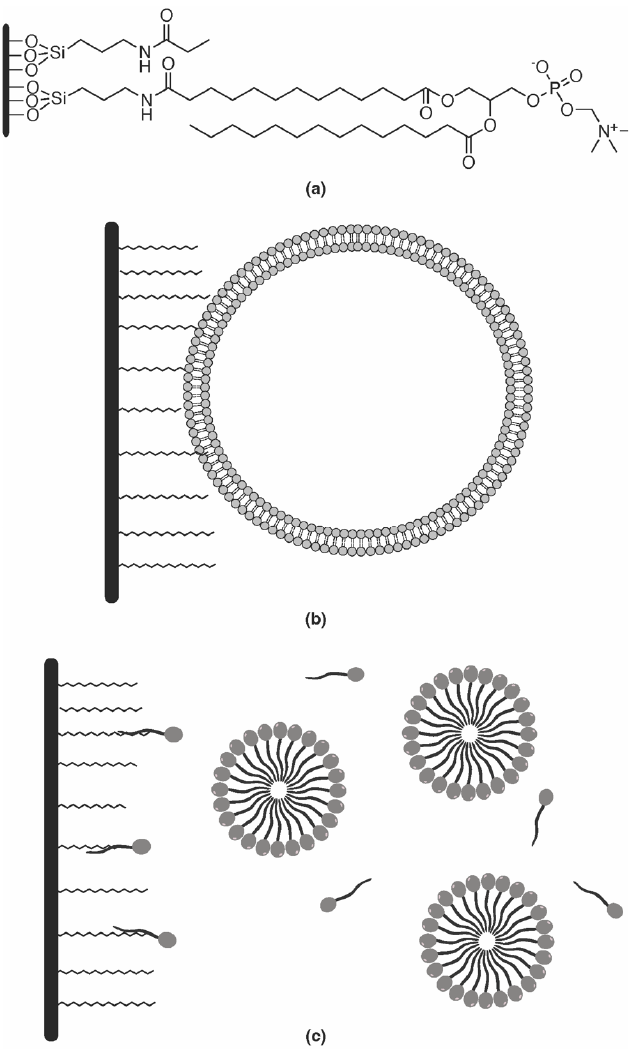
Figure 4. ( a ) IAM HPLC column; ( b ) immobilized liposome chromatography (ILC) HPLC column; ( c ) schematic representation of micellar liquid chromatography